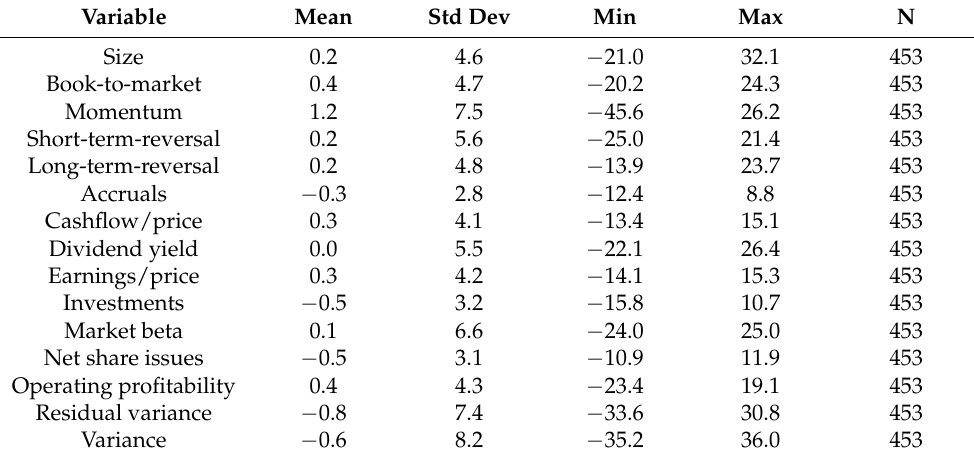
Table 4. Summary statistics relating to the returns of anomaly strategies for the